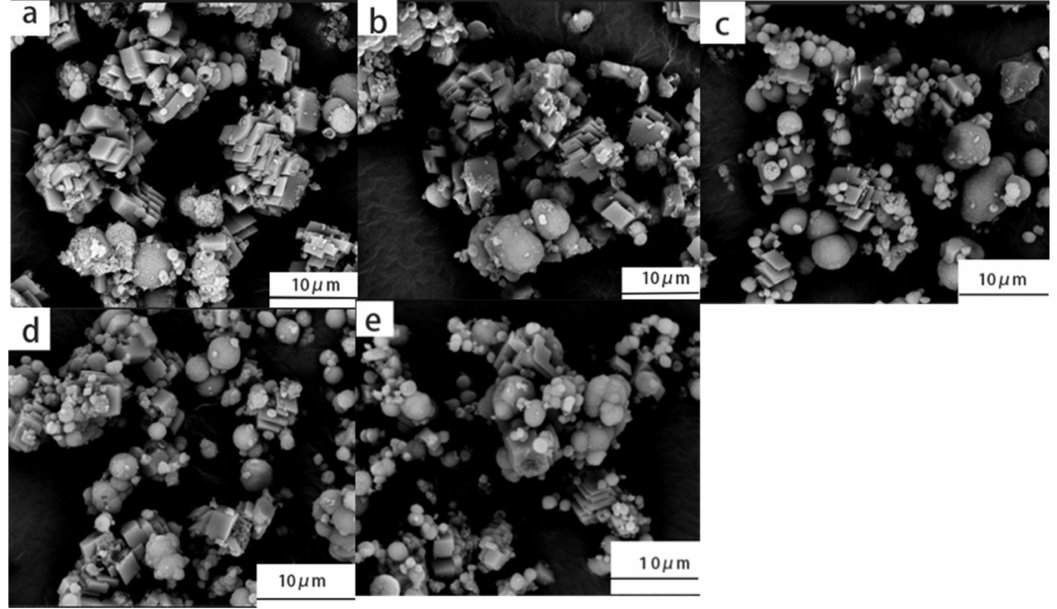
Figure 5. The e ff ects of magnesium sulfate dosage on the morphology of magnetized anti-scaling products: ( a ) 1%; ( b ) 2%; ( c ) 3%; ( d ) 4%; ( e )